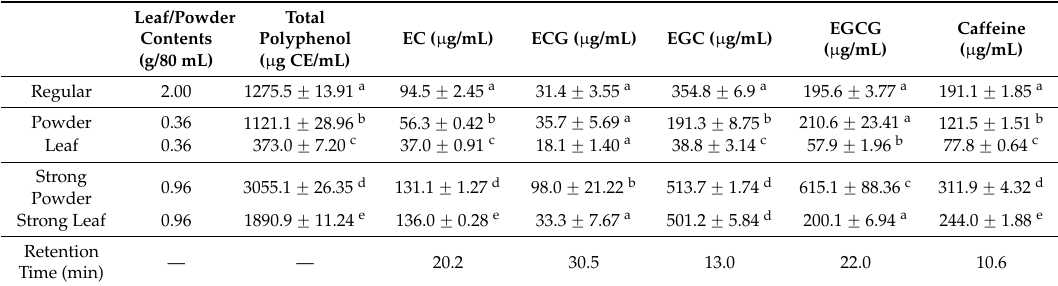
Table 1. Total polyphenol, catechin, and caffeine concentration in green teas by Folin–Denis assay and high-performance liquid chromatography (HPLC)